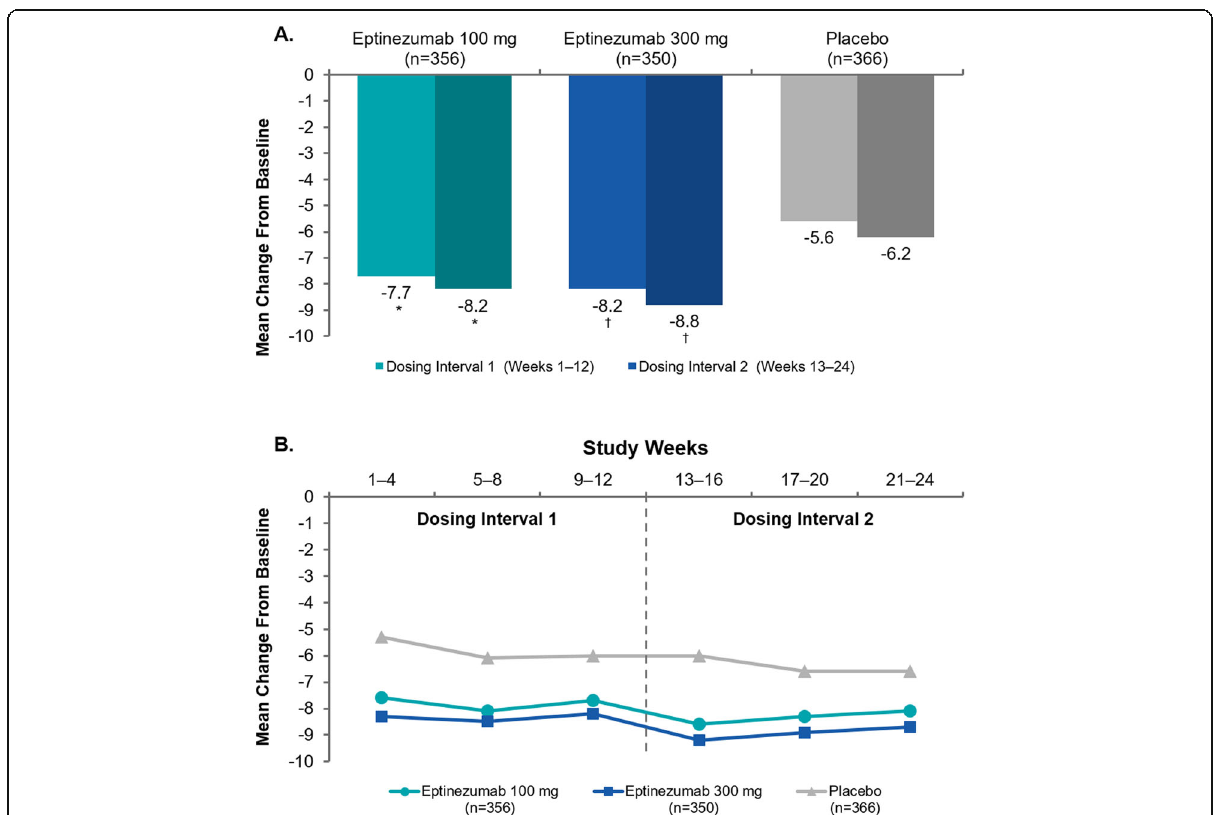
Fig. 2 Reduction in mean monthly migraine days by ( a ) 12-week dosing interval and ( b ) 4-week interval (efficacy population). *P < 0.001 vs placebo. † Nominal P < 0.001 vs placebo (analyses of monthly migraine days over weeks 13 – 24 were not formally tested per the predefined statistical